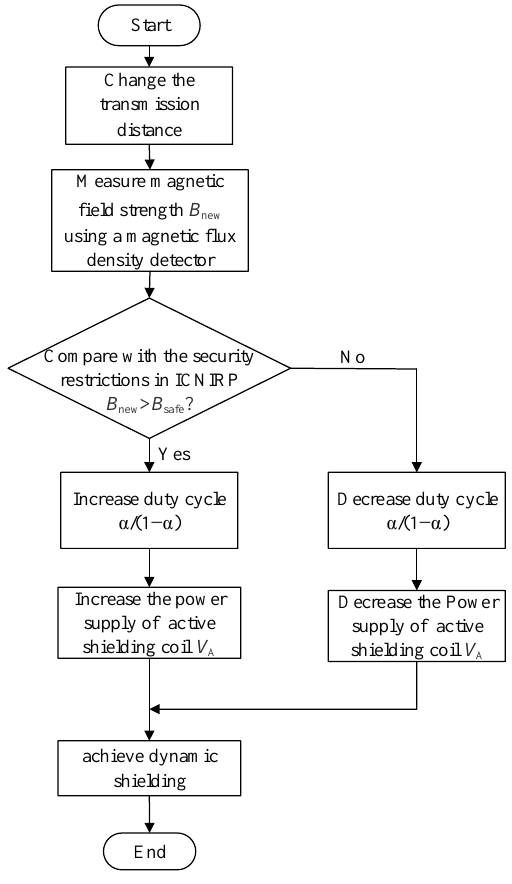
Figure 7. Flowchart of proposed dynamic shielding scheme.